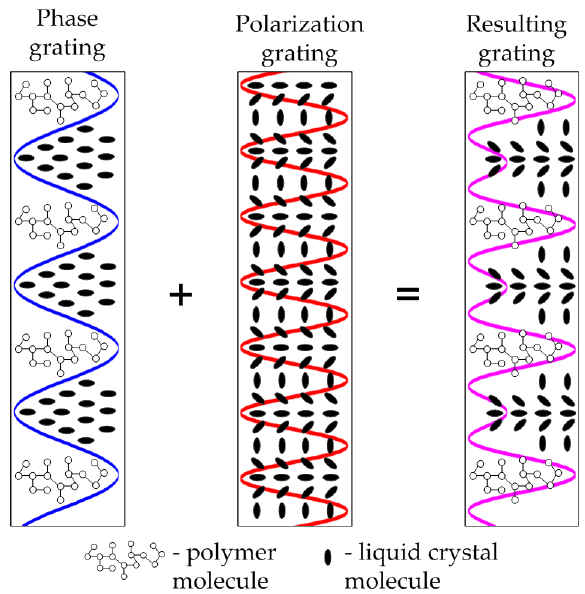
Figure 3. Schematic illustration of HDS being formed by arbitrary polarized waves in PDLC (PSLC).